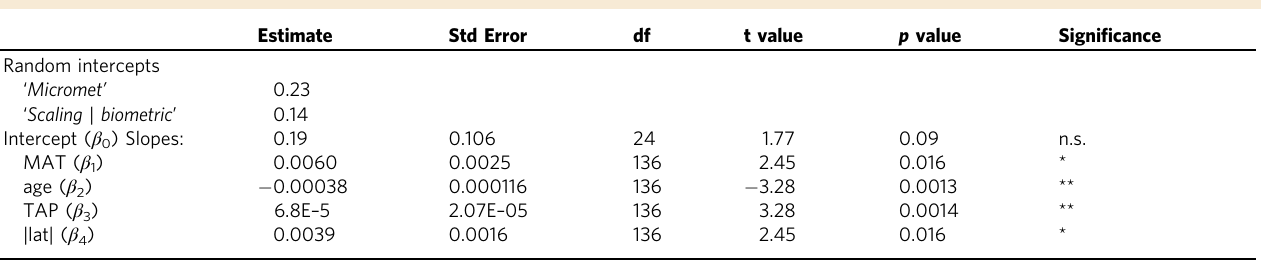
Parameter estimate of coef fi cients in Eq. (1) and their standard errors (Std. Error), degrees of freedoms (df), t- and p values of the two-sided t -test and the ANOVA (* p <0.05, ** p <0.01, *** p <0.001). The squared Pearson ’ s correlation coef fi cient and the squared Spearman ’ s correlation values are both equal to